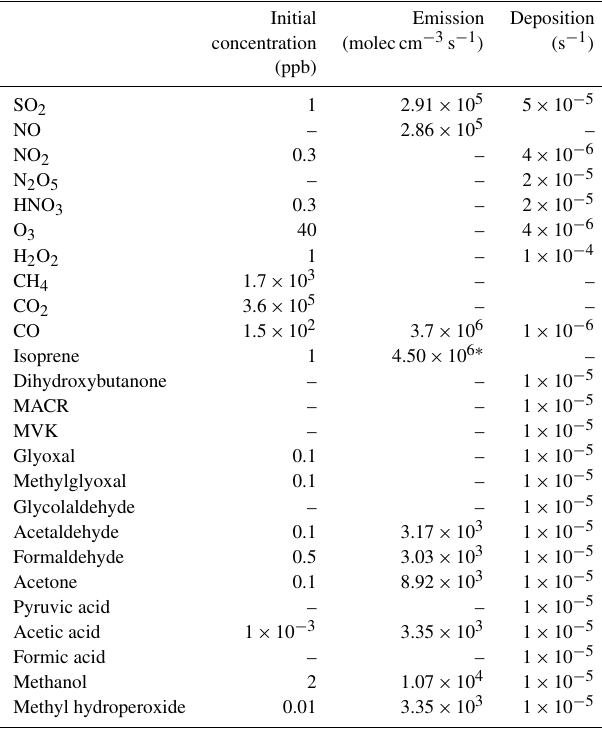
Table 1. Initial gas-phase concentrations, emission and deposition rates adapted from McNeill et al.